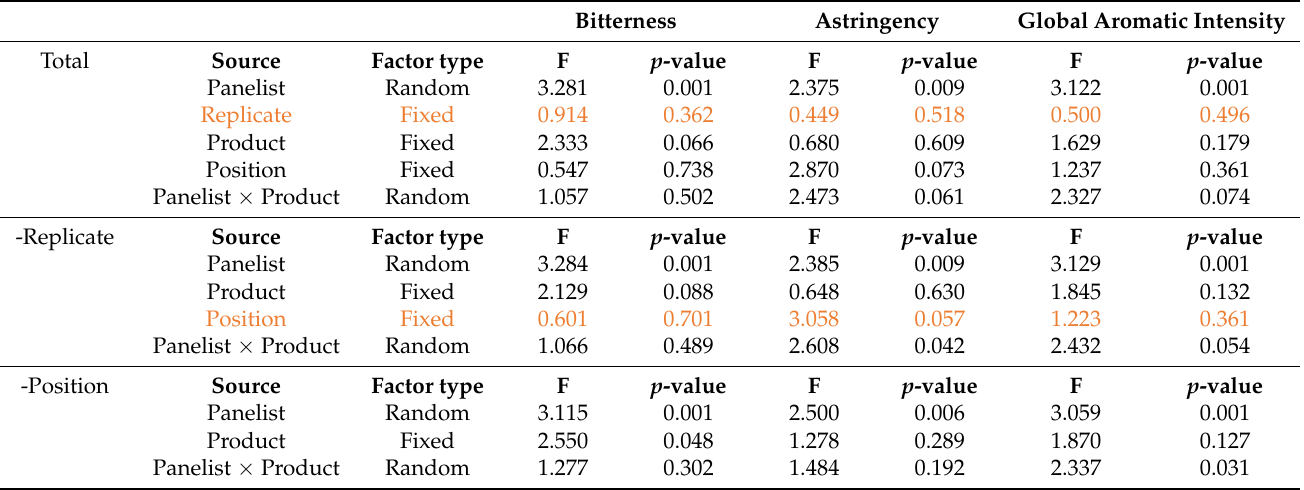
Table A5. Iterative simplification procedure used to assess the significance of the factors for each dependent variable (attribute) in PSPPIC samples. Non-significant factors (in orange) were removed until significant parameters in the model were obtained. The level of confidence was set at